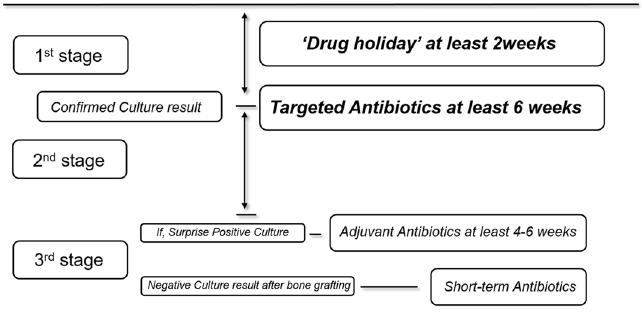
Figure 4. Antibiotics protocol during multi-staged IMT. All patients received at least 2 weeks of an antibiotic drug holiday prior to being engaged in the protocol. Once we identified the microorganisms from the initial debridement, targeted intravenous antibiotics were administered under the guidance of an infectious disease specialist. Intravenous antibiotics were administered for at least 6 weeks. “Surprise culture positive” cases were those in which a positive index culture result followed a negative post-debridement culture result from the previous stage. In such cases, adjuvant targeted IV antibiotics were administered for at least 4 or 6 weeks from the time of last positive